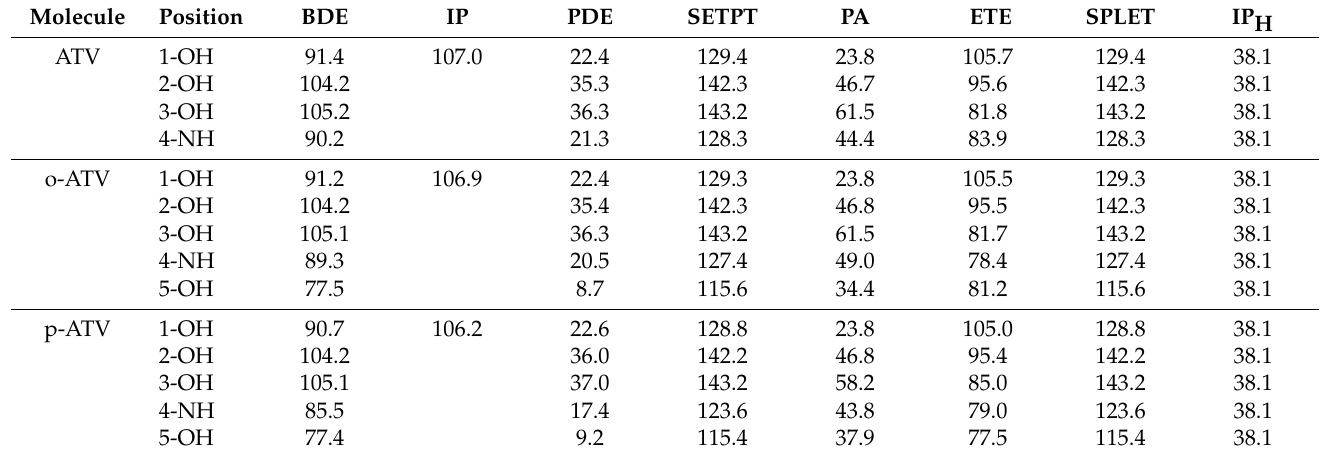
Table 8. The enthalpies of reaction (in kcal/mol) characterizing the antioxidant activity of atorvastatin (ATV) and its ortho- and para-hydroxy metabolites (o-ATV, p-ATV) in methanolic phase [22] (and corrections reprinted [22]) satisfy the two theorems stated in this paper. The values of the difference between IP + PDE = PA + ETE and BDE, identical for all molecular species and positions of H-atom abstraction, are equal to the ionization of the H-atom in methanol computed at the same B3LYP/6- 31+G(d,p) level of theory (cf. Table 4).